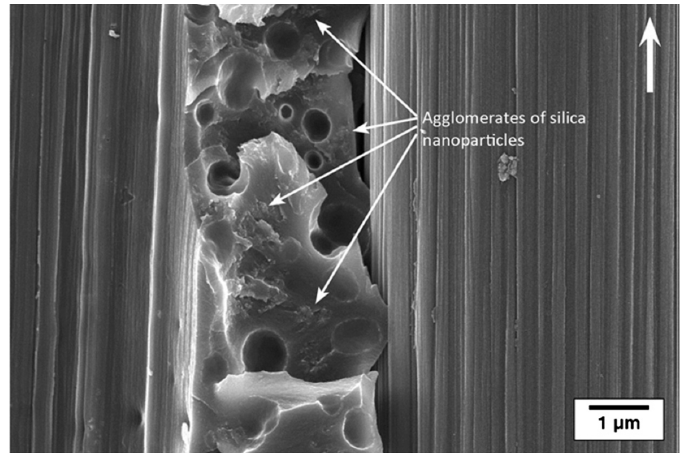
Figure 12. SEM image of carbon/epoxy laminate modified with silica/rubber nanoparticles (fracture surface of G IIc test specimen). The white arrow indicates the direction of crack propagation [68] .